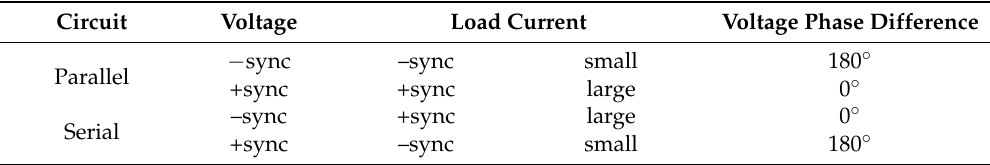
Table 1. Sync in basic circuits